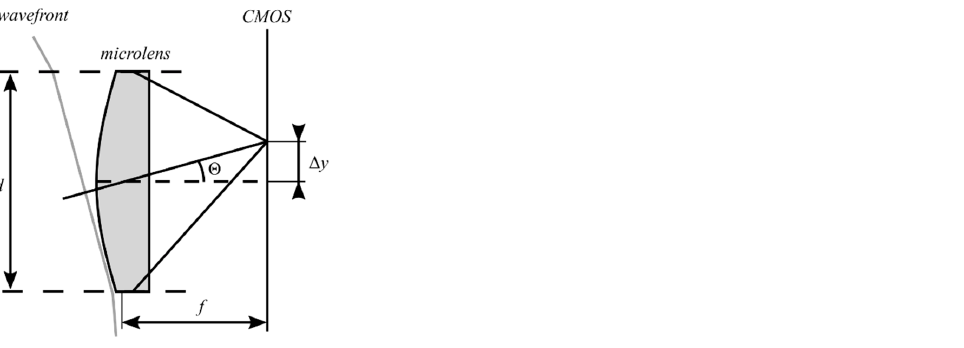
where ∆ y min is the minimum displacement of the light spot in the plane of the CCD that can be detected [39]. For CCD, it can be calculated as ∆ y min = a/ 20, where a = 4.65 μ m is the pixel size of the WFS 300-14AR sensor. Then we get that θ min = 16.37 μ rad.